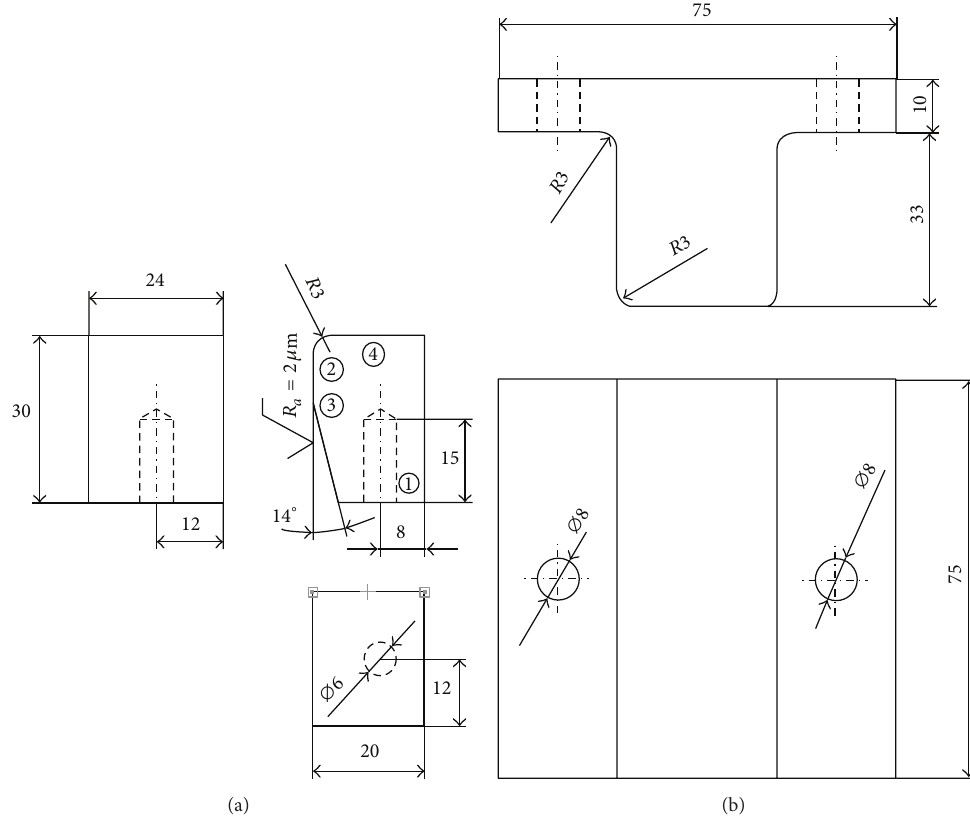
Figure 2: Dimensions (in mm) of the dies (a) and punch (b) used in the hot stamping tests.